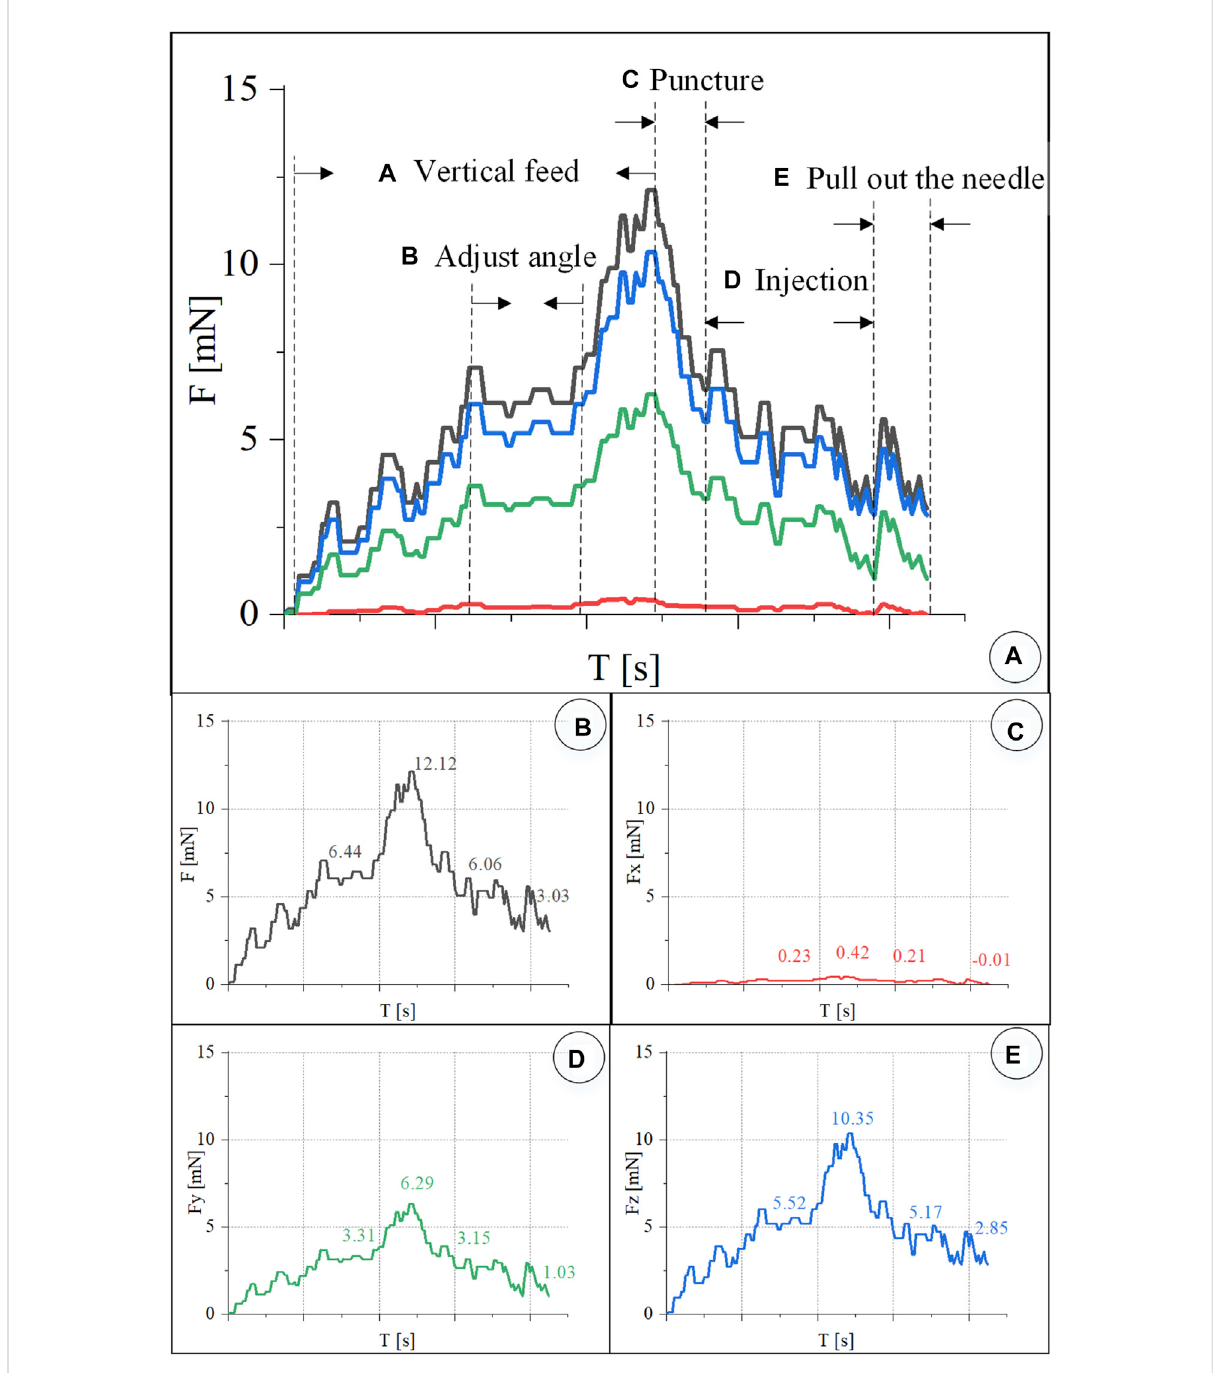
FIGURE 11 Real-time three-dimensional micro-force curve of CAM vascular puncture and injection. (A) Puncture process is divided into linear feed, angle adjustment, puncture, injection, and withdrawal of the sleeve needle. (B – E) Real-time curve of F , F x , F y , F z , respectively.